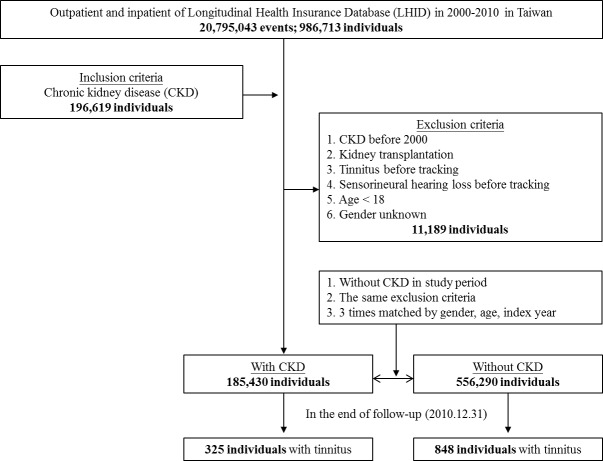
The flowchart of study sample selection from National Health Insurance Research Database in Taiwan.